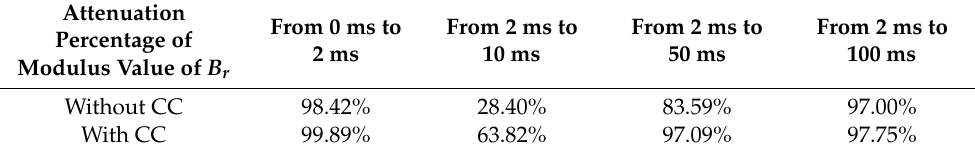
Table 4. Attenuation percentage of modulus value of B r without and with CC at di ff erent times.